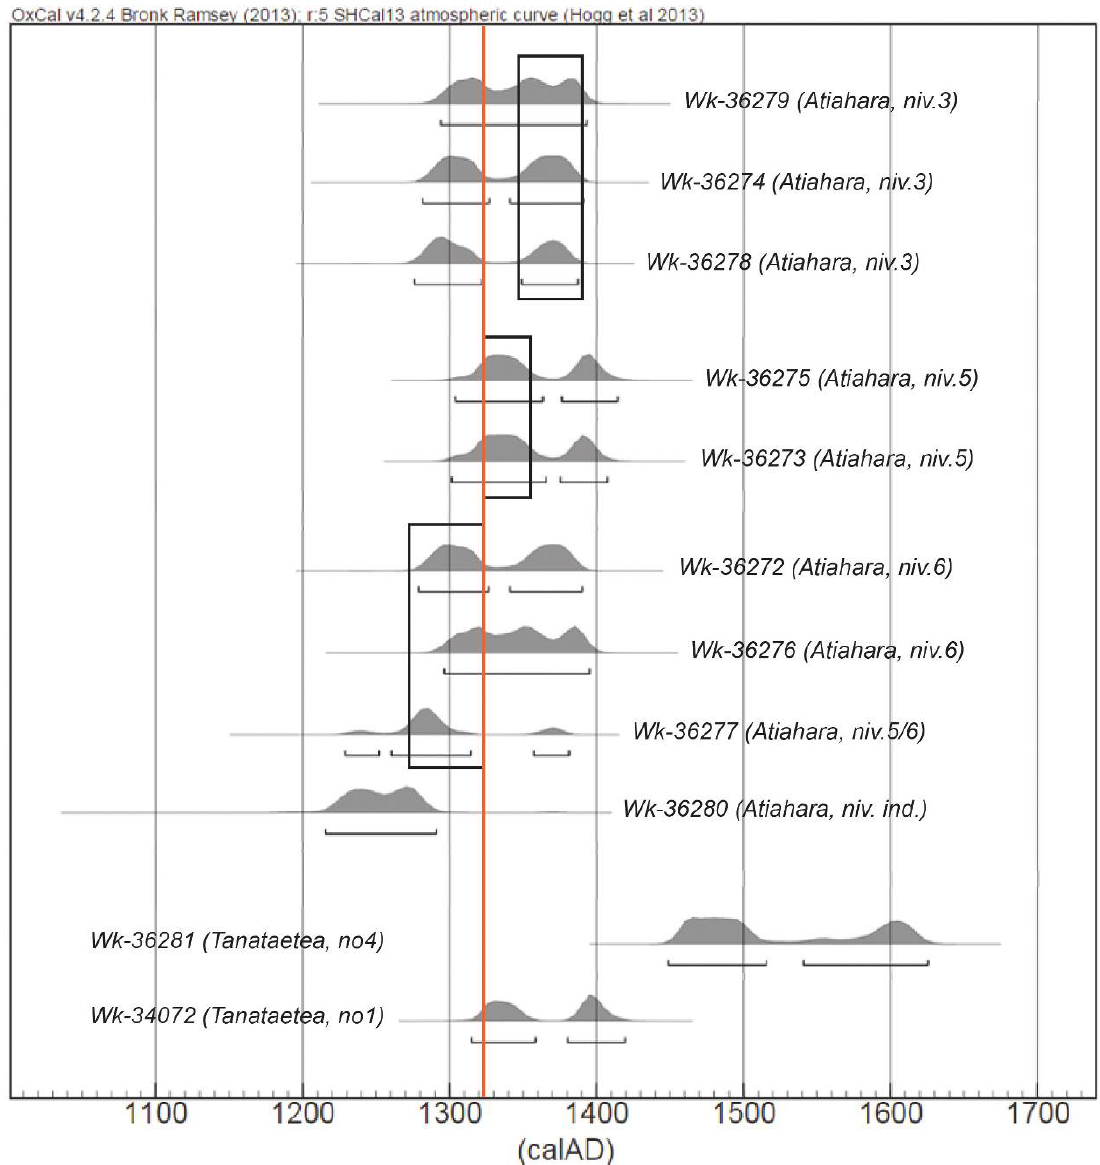
Figure 4. Datations calibrées des sites d'Atiahara et de Tanataetea, réalisé avec OxCal 4.1.7. (Bronk Ramsey et al. 2013) et calibré en utilisant la courbe de calibration 'SHCal13' (Hogg et al. 2013). Figure 4. Calibrated dates for the Atiahara and the Tanataetea